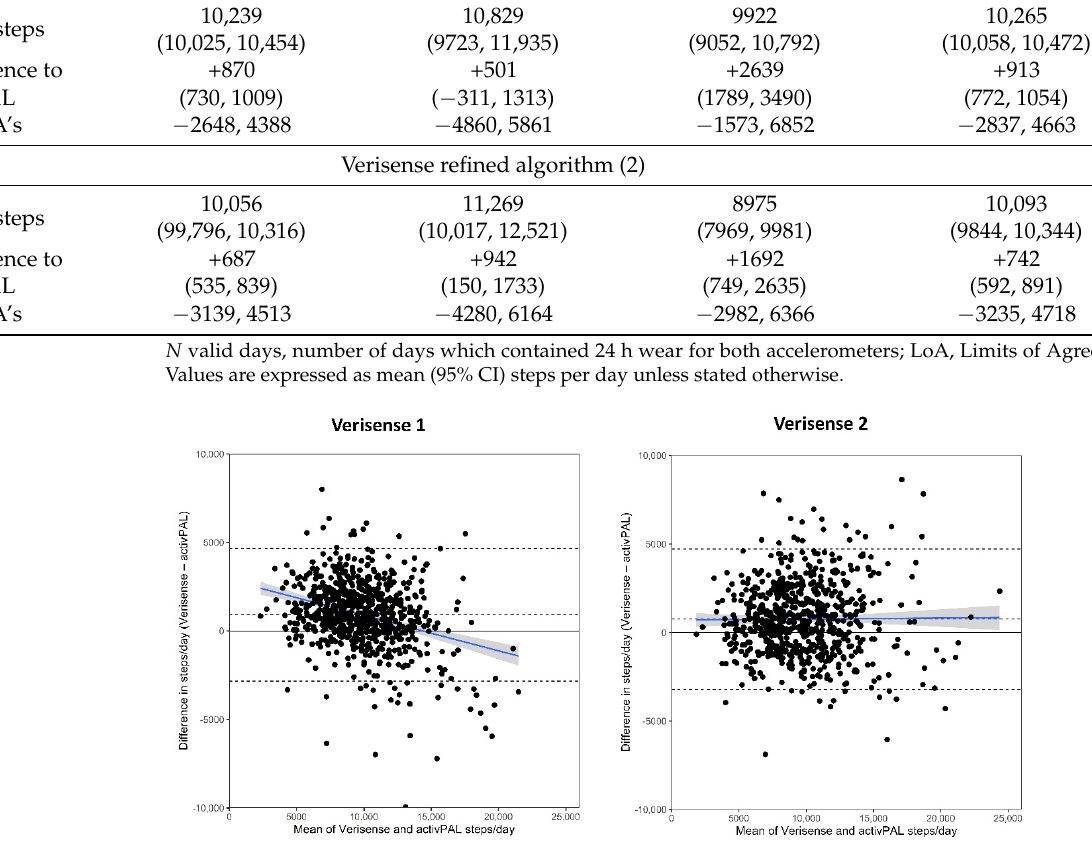
Figure 1. Bland–Altman plot showing the differences in total steps/day derived from the Verisense 1 and Verisense 2 algorithms compared with the activPAL across the mean total steps/day for the overall sample. The blue line depicts mean (95% CI) proportional bias. Dashed black lines depict ± 95% limits of agreement and mean bias. LoA, Limits of Agreement.